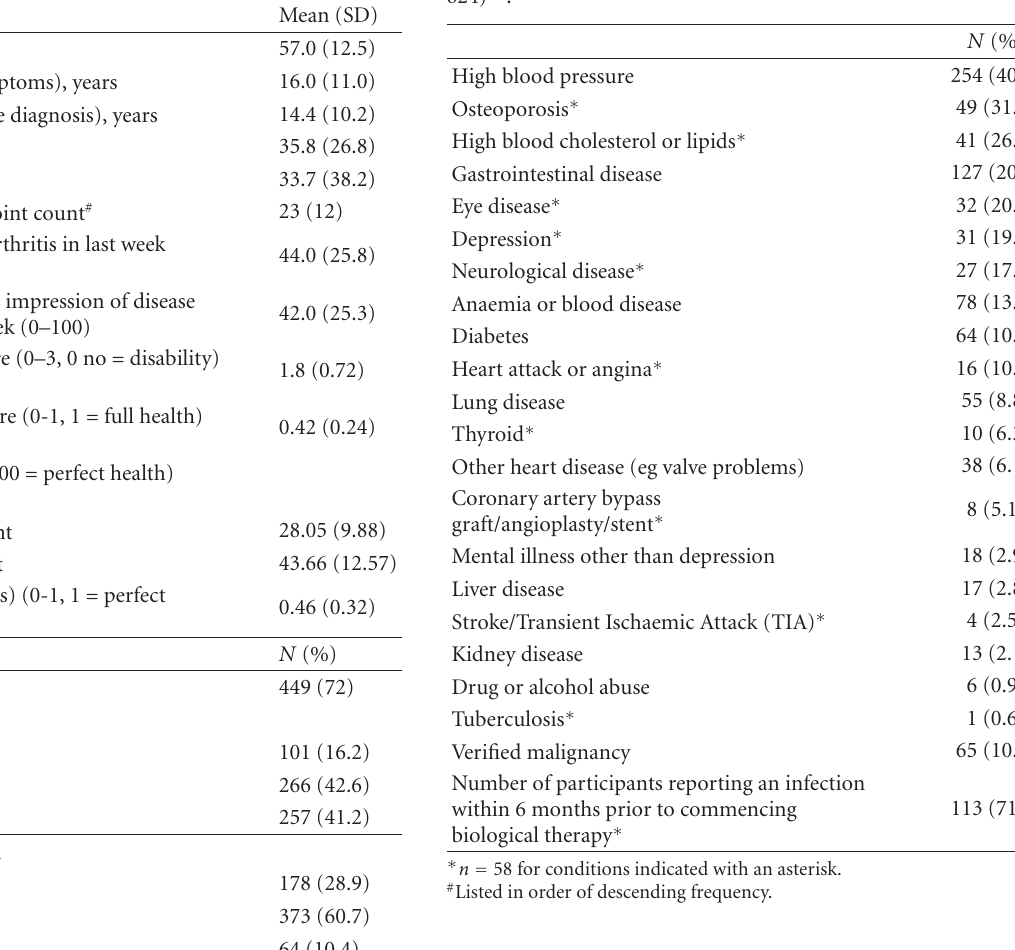
Table 2: Baseline demographic and disease characteristics of the ARAD RA cohort ( n = 624) ∗ .